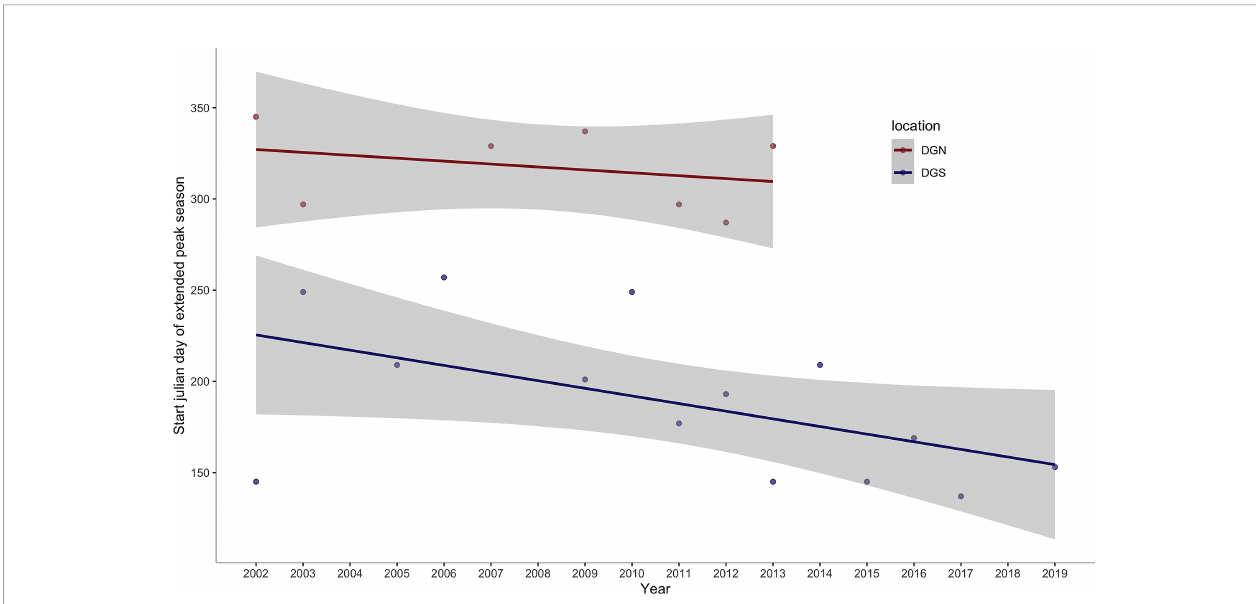
FIGURE 8 | Annual change in the start julian day of the fi rst extended peak season per year off Diego Garcia at the DGN site where the linear trend has a slope of -1.6 days/ year (sample size is too small to calculate a p-value) and DGS site where the linear trend has a slope of -4.2 days/year with corresponding r of -0.53 and p -value of 0.05. r is the spearman coef fi cient of the start julian day of the fi rst peak season with